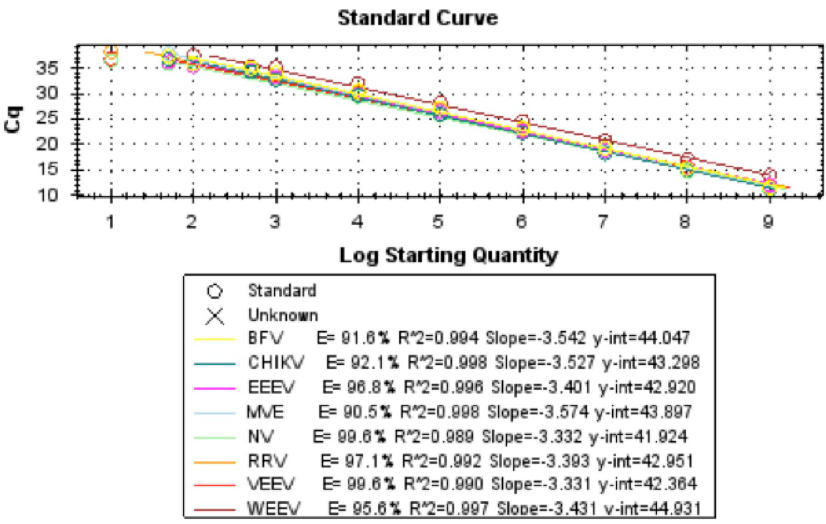
Fig 3. Results obtained using the pan-alphavirus assay (Cycle threshold (Ct) from a single PCR replicate). The standard curve was plotted using the log10 concentration versus Ct value.